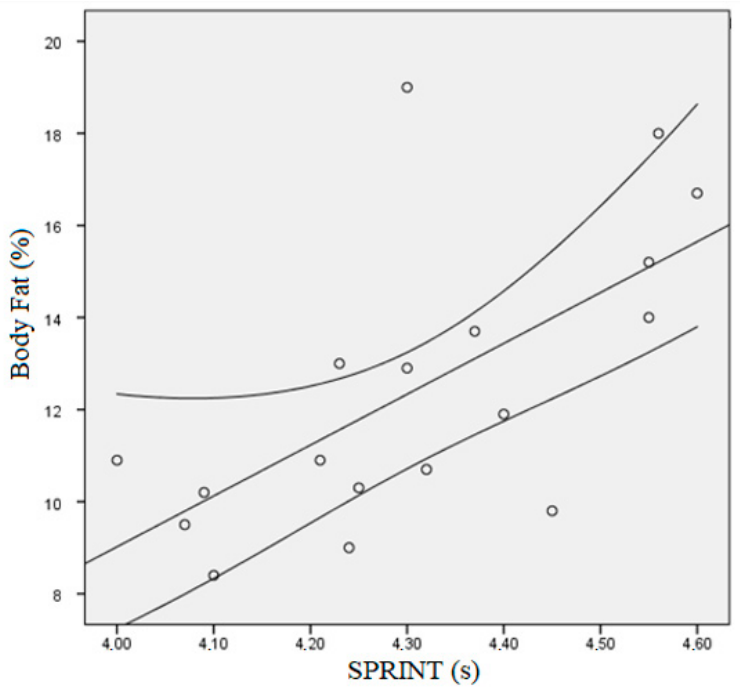
Figure 6. Scatter plot between Body Fat and 30-m Sprint. The middle line represents the median and the parabolic lines represent the 95% confidence interval.